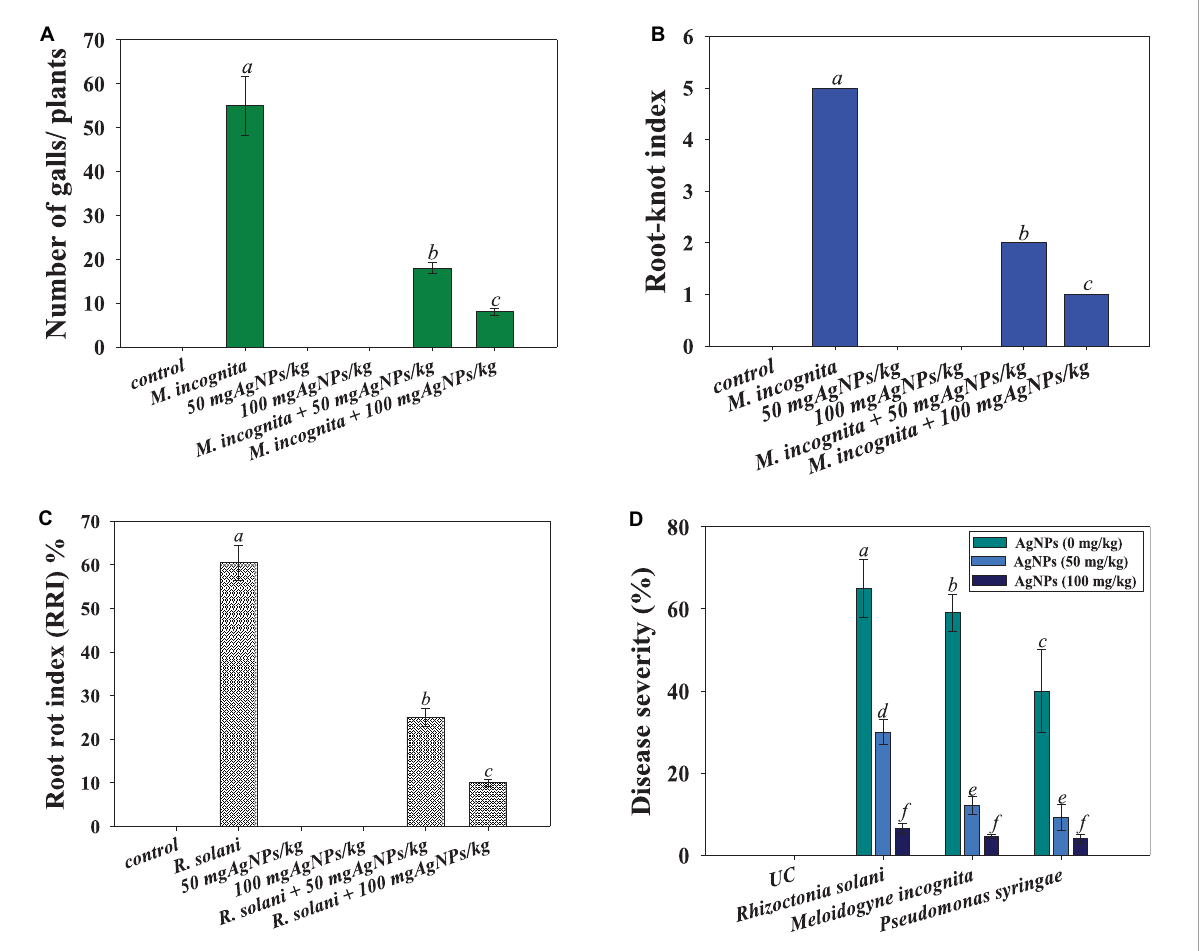
FIGURE7 Effect of Ag@ Cf L-NPs on number of galls caused by M. incognita (A) , root-knot index (B) , root-rot index (C) and percent disease severity (D) in tomato crop cultivated in pot and infected with phytopathogens; P. syringae , M. incognita , and R. Solani . In this figure, bar diagrams represent the mean values of three replicates ( n = 3). Corresponding error bars represents standard deviation (SD) of three replicates (S.D, n =